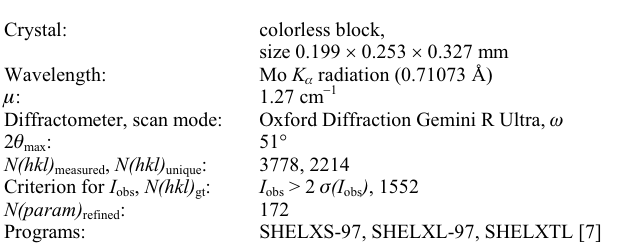
Table 1. Data collection and